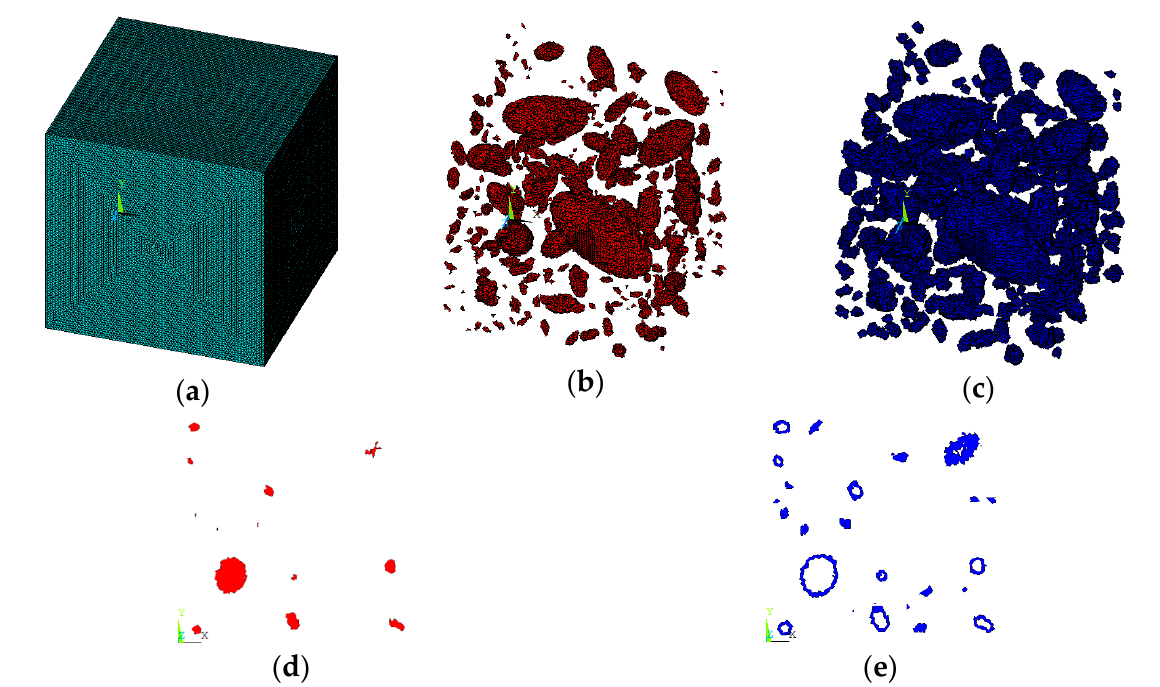
Figure 5. Mesh diagram of mortar, aggregate and ITZ elements in the ellipsoidal aggregate model,